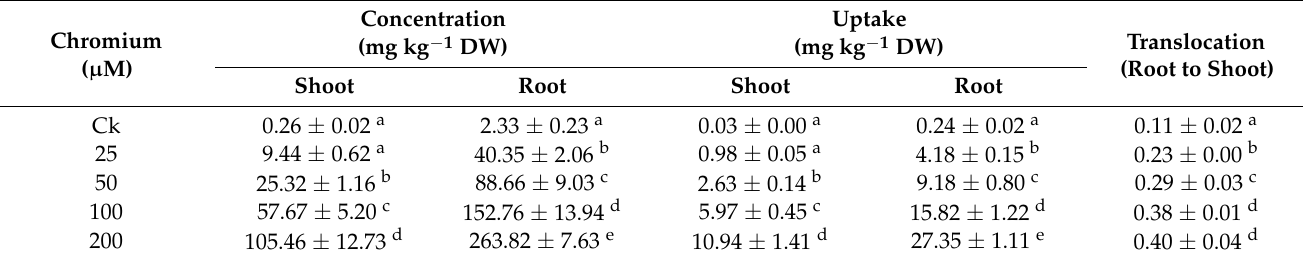
Table 5. Impact of Cr in the content of Cr in the sweet potato.